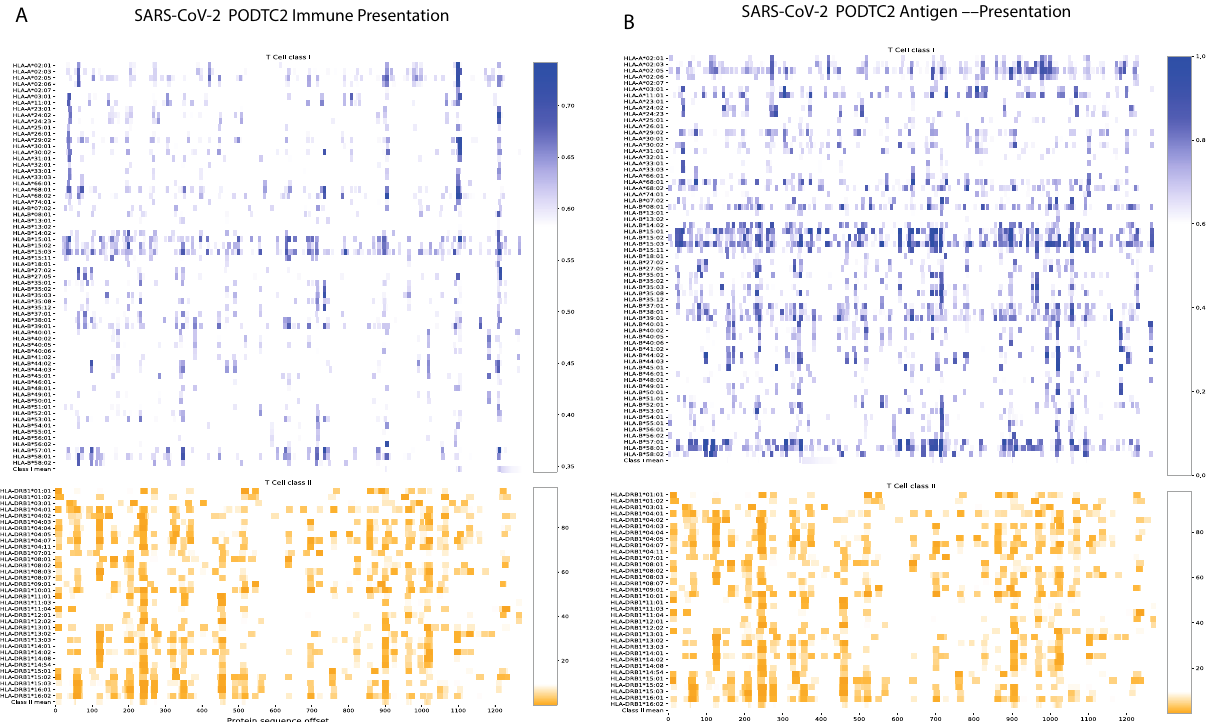
Figure 1. Epitope map of the S-Protein (PODTC2) across the most frequent HLA-A, HLA-B and HLA-DRB alleles in the human population. Data is transformed such that a positive results for CD8 relates to 0.7 or above, and 0.1 or below for Class II. Broad coverage for CD8 and CD4 is demonstrated. PODTC2 is the Uniprot accession ID for the S protien (spike glycoprotien of